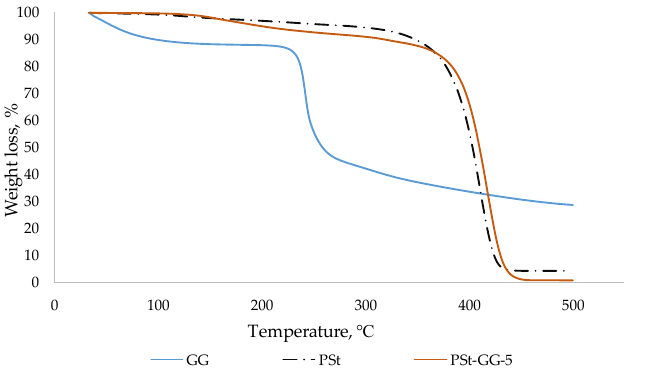
Figure 8. Thermograms of GG (blue line), linear PSt (dotted line), and PSt-VBzGG-5 SIPN (orange line).